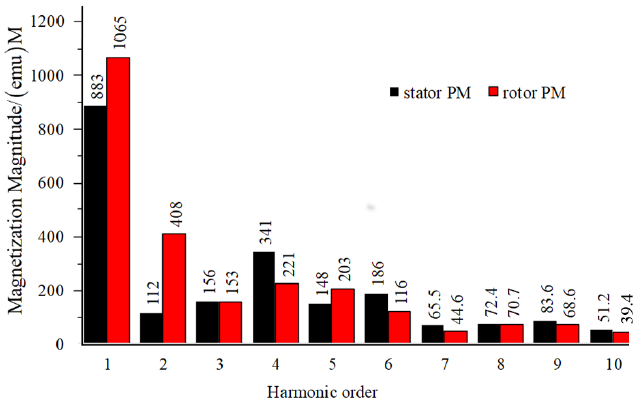
Figure 5. The magnetization magnitude of the harmonic of the PMB.